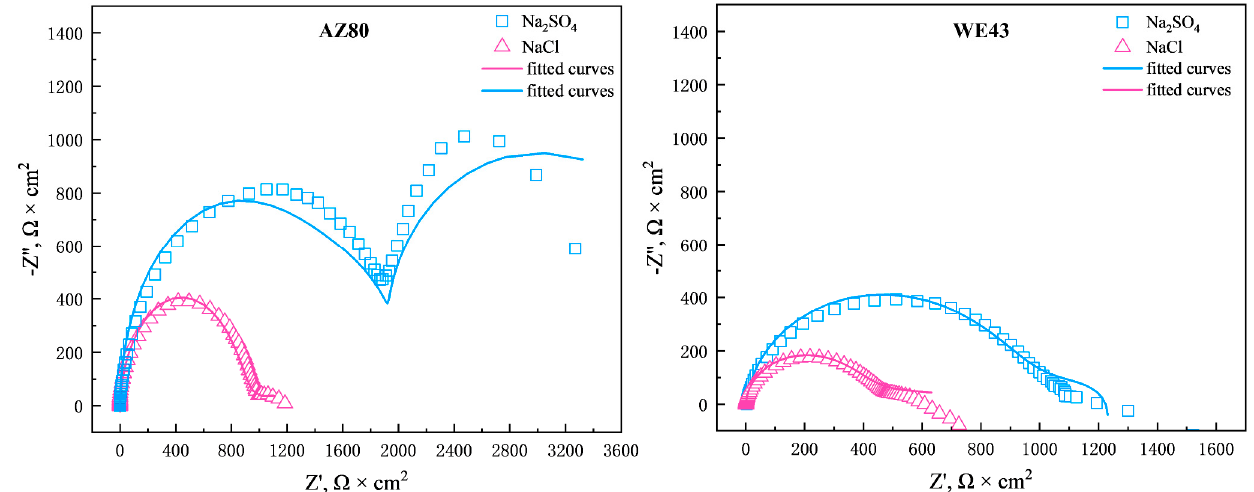
Figure 11. Nyquist curves of AZ80 and WE43 alloys in 0.6 M NaCl and Na 2 SO 4 solution.